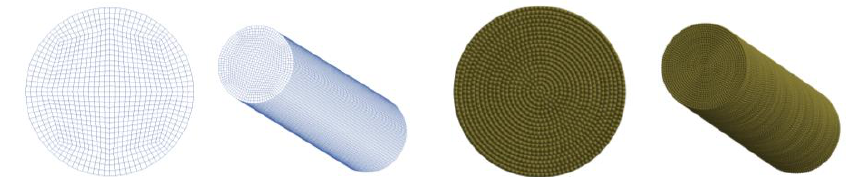
Fig. 2. FEM meshed sample (left) and SPH sample (right).